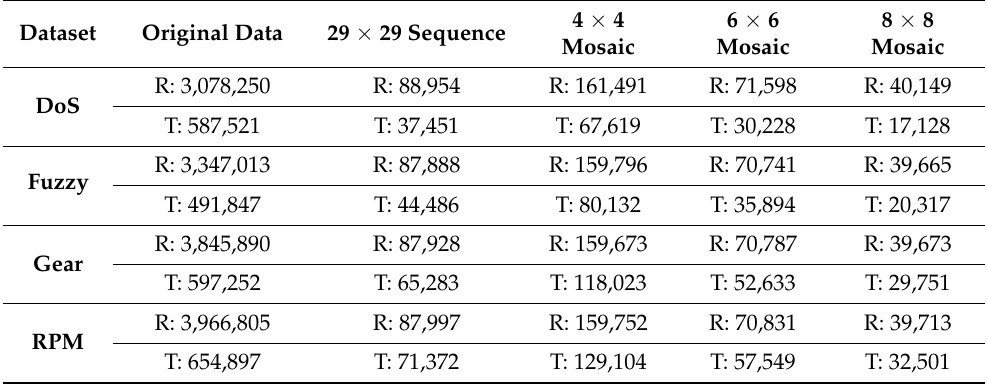
Table 1. The numbers of normal (R) and attack (T) samples, for each coding method.